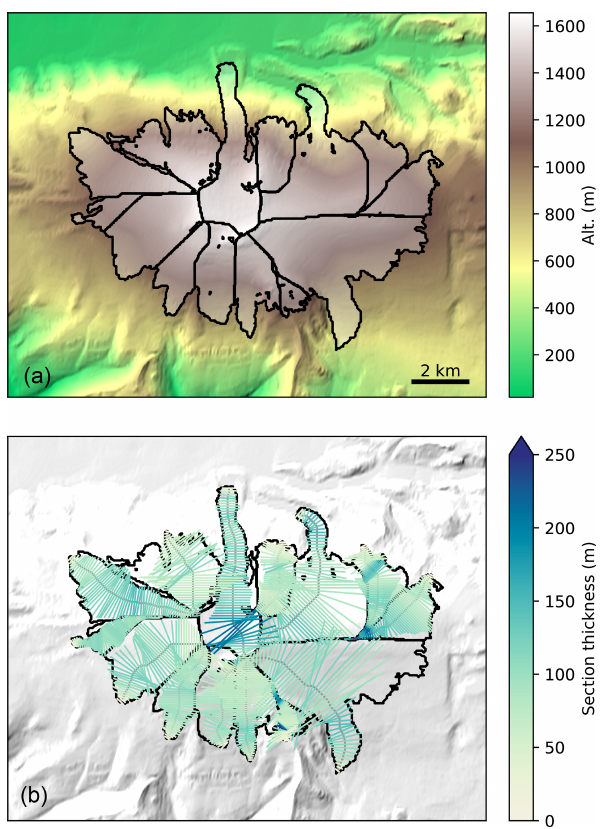
Figure 9. The OGGM inversion workflow applied to the RGI enti- ties of the Eyjafjallajökull ice cap, Iceland. (a) Outlines and topog- raphy. (b) Glacier